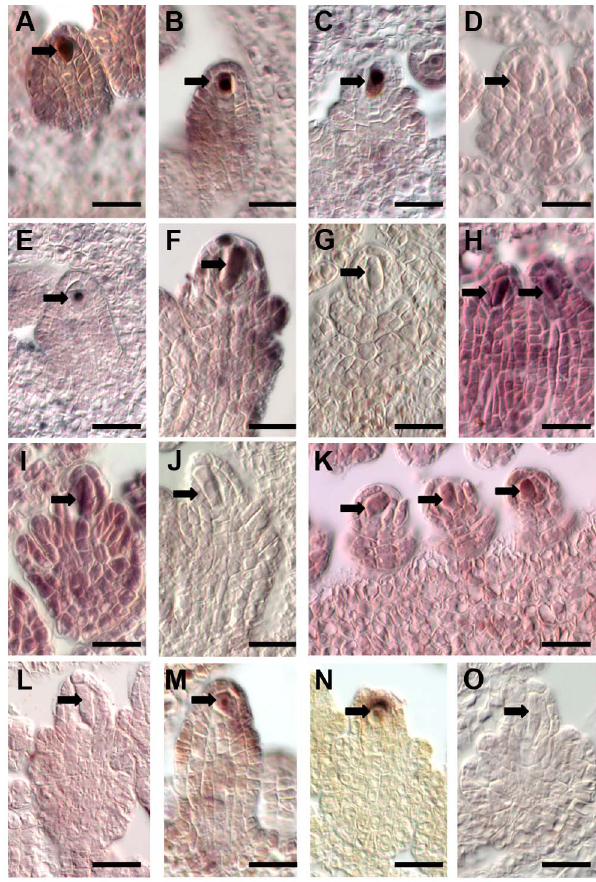
Figure 3. Independent data validation for selected genes by in situ hybridization on B.gunnisoniana ovules. Data validation for selected genes found expressed in the Boechera AIC but not the Arabidopsis MMC. Scale bars are 20 m m, arrows point to the AICs. In situ hybridizations on B. gunnisoniana ovule sections were performed with antisense probes (A–C, E, F, H, I, K, M, N) or sense probes as controls (D, G, J, L, O) for the transcription factors AT1G06170, a basic helix-loop- helix (bHLH) DNA-binding superfamily protein (A–D), AT1G28050, a B- BOX DOMAIN PROTEIN 13 (E–G), and AT1G76580 a Squamosa promoter- binding protein-like (SBP domain) transcription factor family protein (H– J), an oligopeptide transporter, AT1G59740 (K,L), and AT1G14900, encoding the HIGH MOBILITY GROUP A